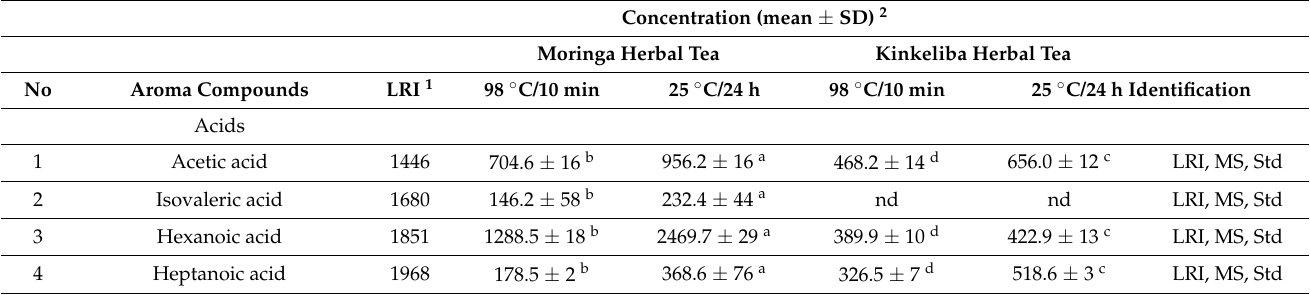
Table 2. Aroma profiles of Moringa and Kinkeliba herbal tea